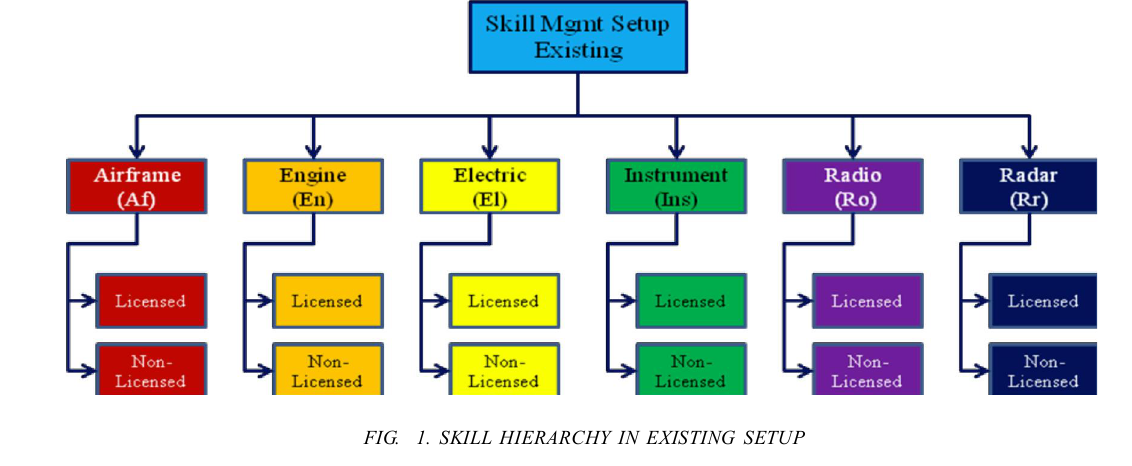
FIG. 1. SKILL HIERARCHY IN EXISTING